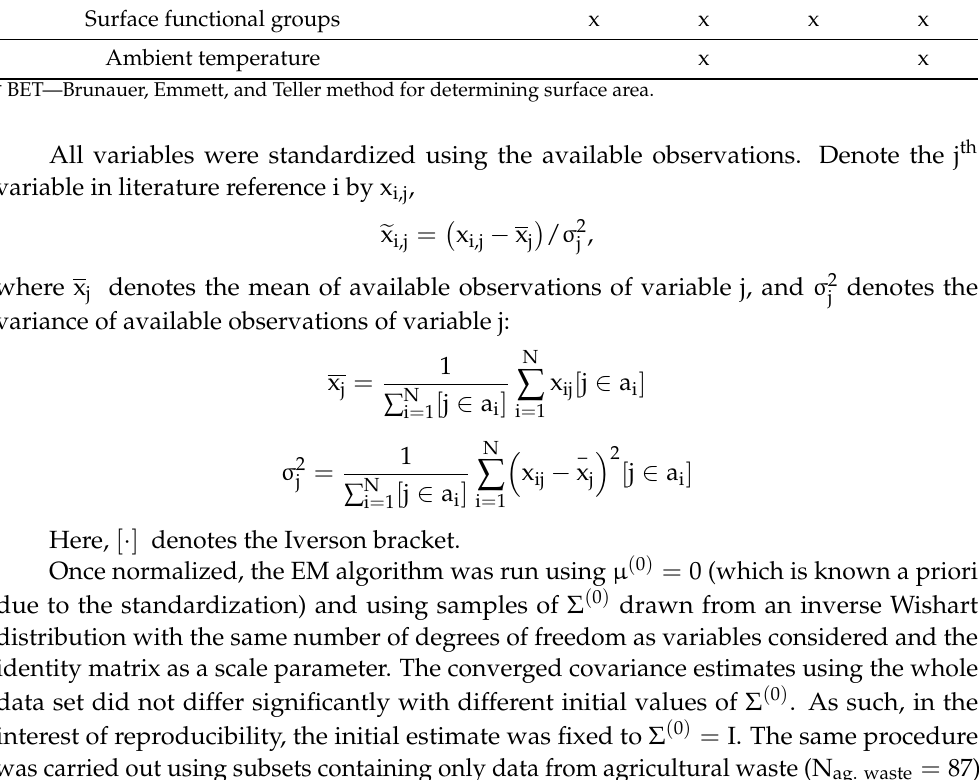
Table 1. Cont. Influencing Factor Cation exchange capacity (CEC) x Surface functional groups x x x x Ambient temperature x